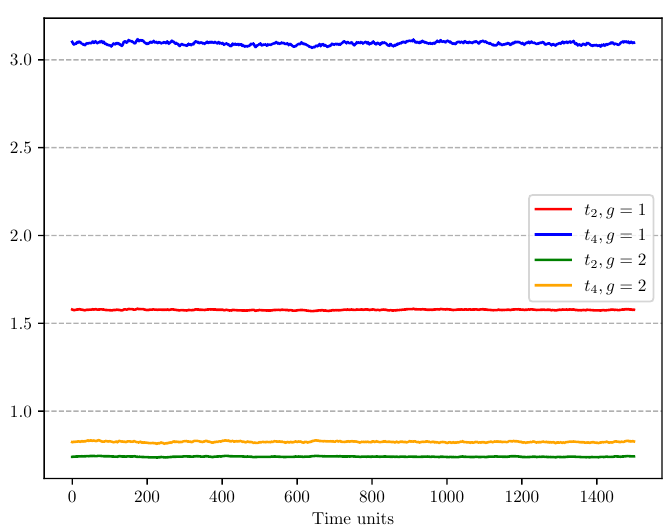
Figure 14: We show the expectation value for N = 300, c = κ = 1.35 for two